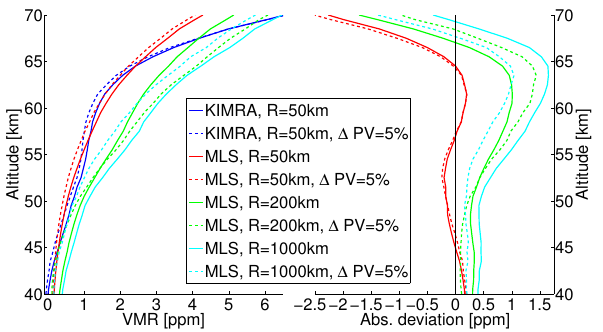
Fig. 12. Investigation of the influence of the PV collocation crite- rion using the MLS dataset in a constant radius of R =1000km. Left panel: mean profiles derived according to Sect. 5.1. Right panel: deviation between the KIMRA and the satellite profiles calculated with Eq.